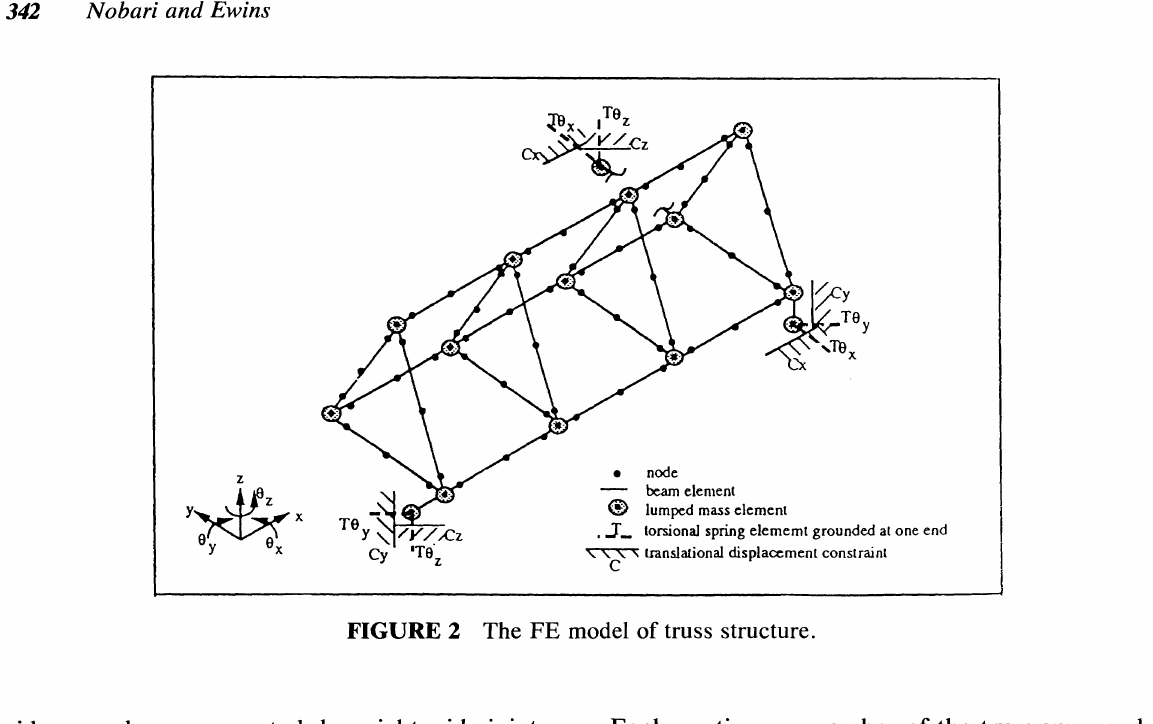
FIGURE 2 The FE model of truss structure.